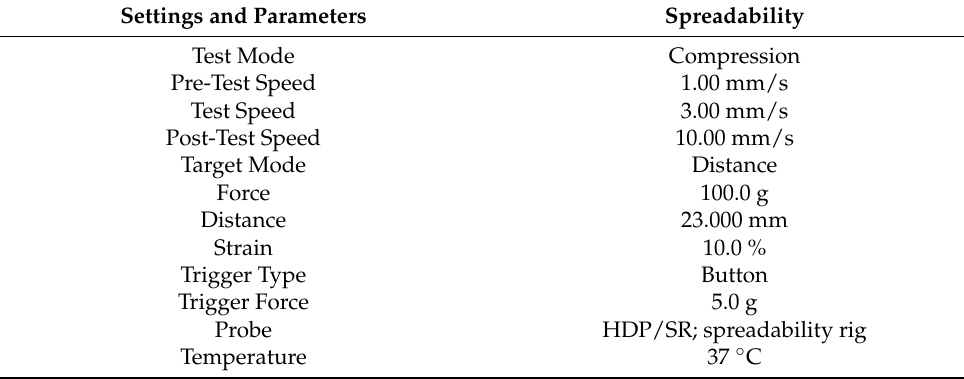
Table 1. Settings and parameters of spreadability analysis using a TA.XT plus texturometer. Settings and